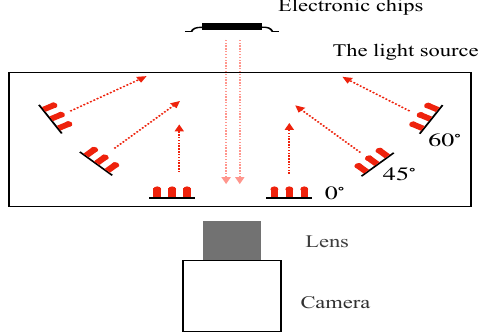
Figure 4. Structure of the chip detection